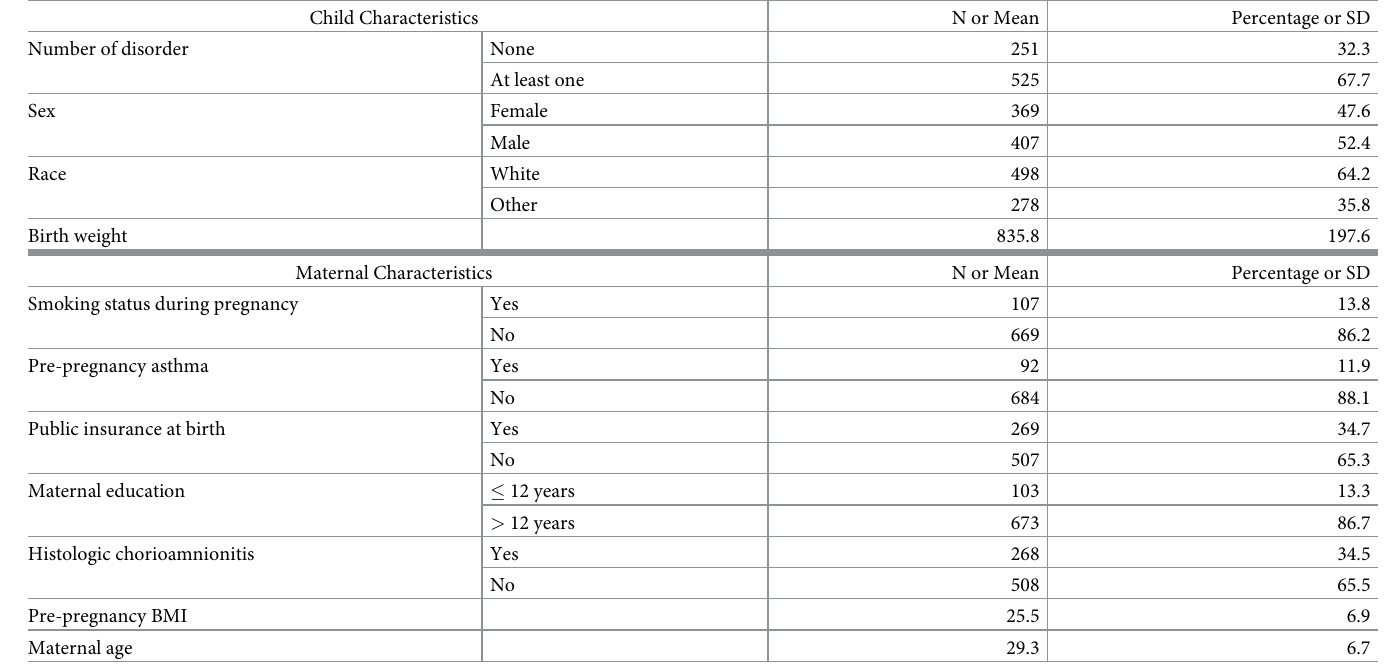
Table 1. Distribution of child and maternal